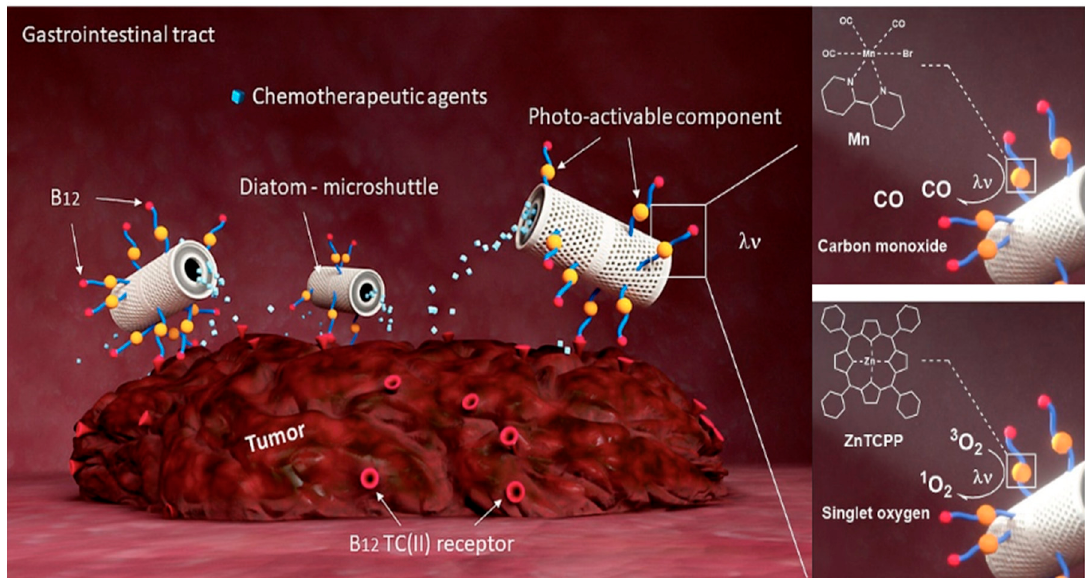
Figure 2. Left: Concept showing the bio-inspired hybrid drug delivery system described by Delasoie et al. [45]. Diatom frustule surface was functionalized with photoactivable molecules (orange spheres) linked to vitamin B-12 (red sphere) acting as a tumor-targeting tag. The system can be loaded with chemotherapeutic drugs (light blue spheres), which can be selectively delivered to colorectal cancer cells. Besides, diatomite microparticles can be photoactivated to generate carbon monoxide or free radicals inducing tumor cell apoptosis. Right: Photo-induced chemical reactions at the surface DEM. Reproduced from [45].